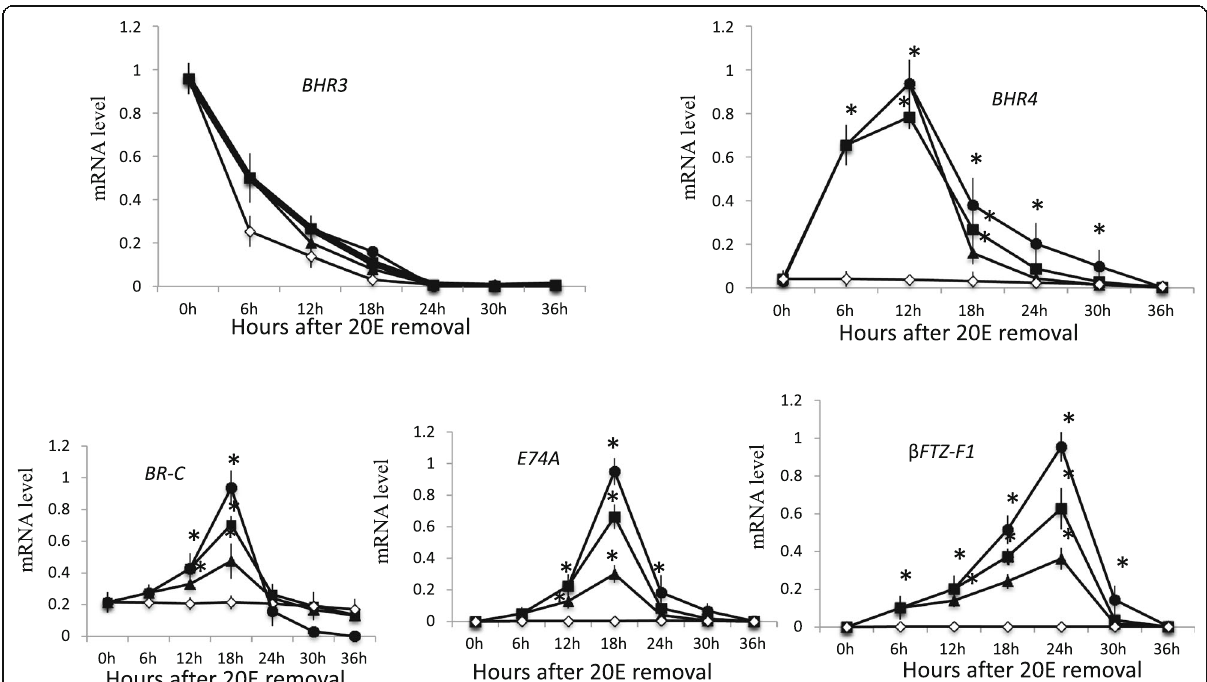
Fig. 4 Effect of cycloheximide treatment on the ERTF expression after 20E pulse treatment. Wing discs of the W2 stage were incubated 12 h in a medium containing 2 μ g/ml 20E and then transferred to a hormone-free medium with (open circle) or without cycloheximide (50 μ g/ml) for the indicated time. RNA was extracted from wing discs and reverse-transcribed to cDNA for use in qRT-PCR. Values were first normalized to rpl and then plotted relative to the highest value for each panel. The highest expression level of each gene was designated as 1. Level of mRNA after ecdysone pulse treatment. Each datum was calculated from three independent experiments. The result is expressed as the mean ± S. E. M. Asterisks indicate p < 0.05 significance by the Student ’ s t test. Level of mRNA of the ecdysone